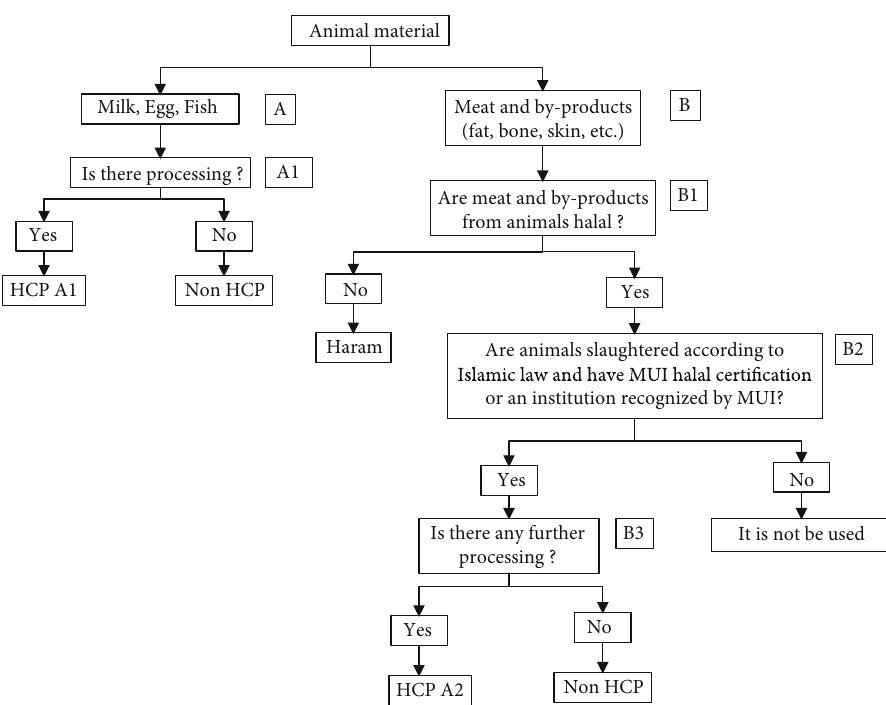
Figure 1: Decision tree for identi fi cation of Halal Control Points for animal materials (source: [21]). The explanation is as follows: A: list of questions for animal ingredients, milk, eggs, and fi sh; B: list of questions for animal ingredients and by-products (fat, bones, skin, etc.); number: question sequence. Table 2: HCP identi fi cation data of animal materials in bakery based on decision trees. Bakery